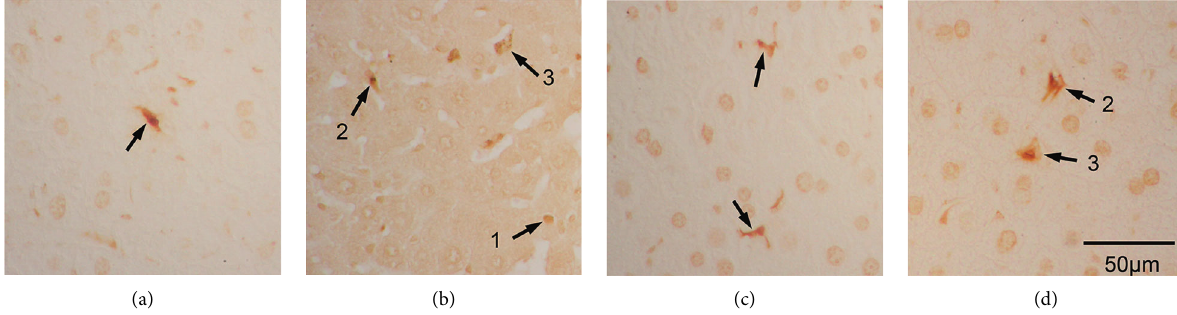
Figure 4: TUNEL-positive cells in the saline- (a), ethanol- (b), fluoxetine- (c), and atorvastatin-treated (d) liver. Arrows denote positive cells; 1 denotes a possible positive liver cell; 2 denotes a possible Kupffer cell; and 3 denotes a possible stellate cell, 400X.